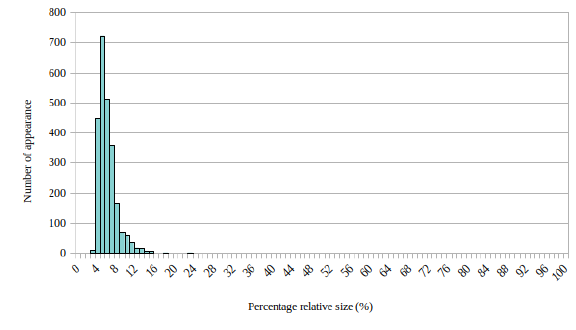
Figure 1. TomatOD dataset percentile object size